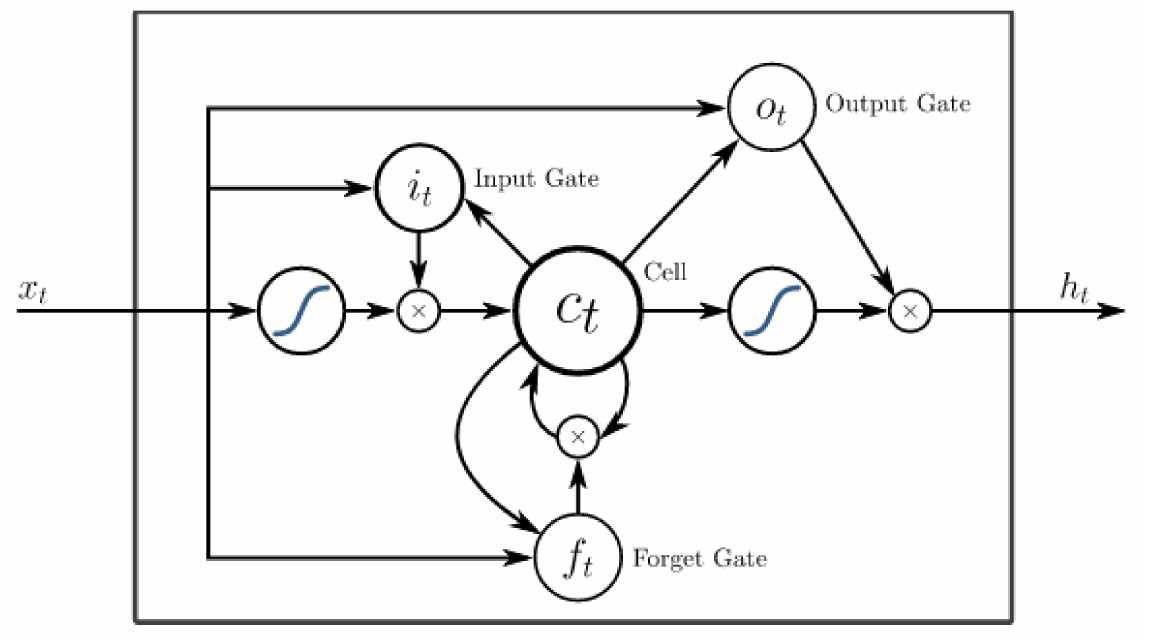
Figure 1. LSTM System. Sources: Refs. [21,22] (accessed on 8 March